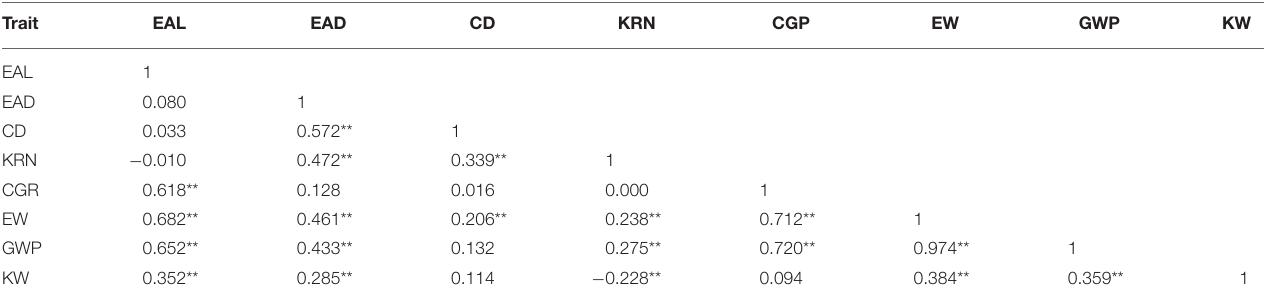
EW 0.682** GWP 0.652** KW